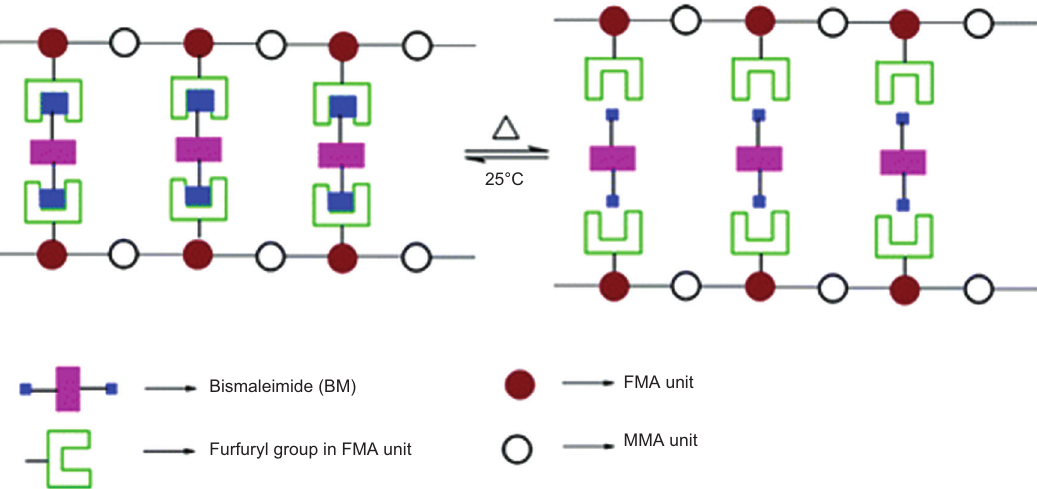
Figure 12 Image of a self-healing system by using furan units in the side chain (reprinted with permission from [61]. Copyright 2009, American Chemical